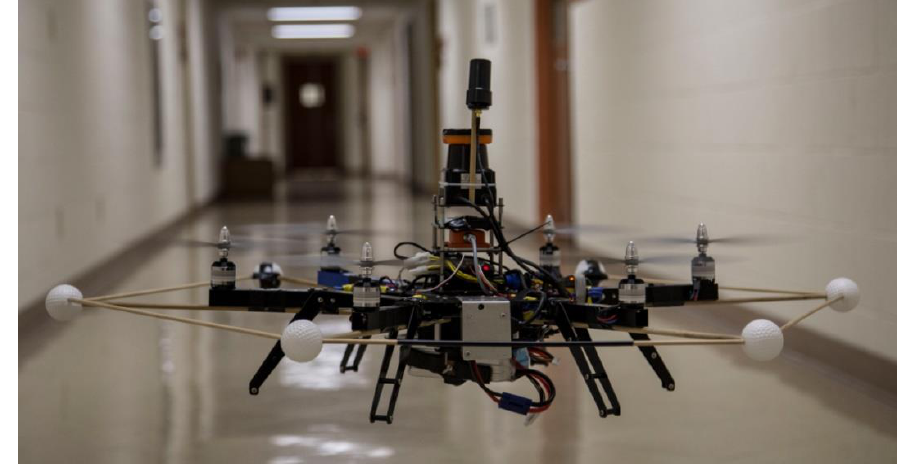
Figure 3. 3DR hexacopter with sensor payload while flying in the Stocker center